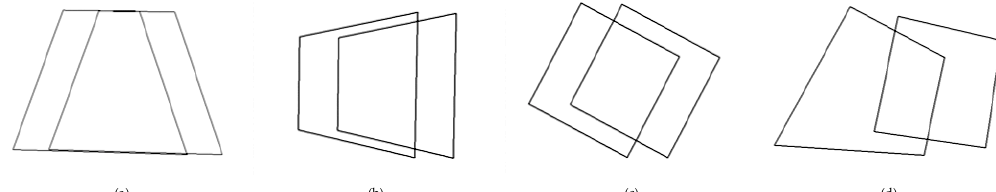
Figure 4. Views of the stereo model and overlaps with different rotation angles. ( a ) the effect of only roll angle at value 15°; ( b ) pitch at 15°; ( c ) yaw at 30°; ( d ) the effects of the three rotation angles (roll, pitch, yaw) at (10°, − 10°, 7°) for left image and (3°, − 3°, 7°) for right image.